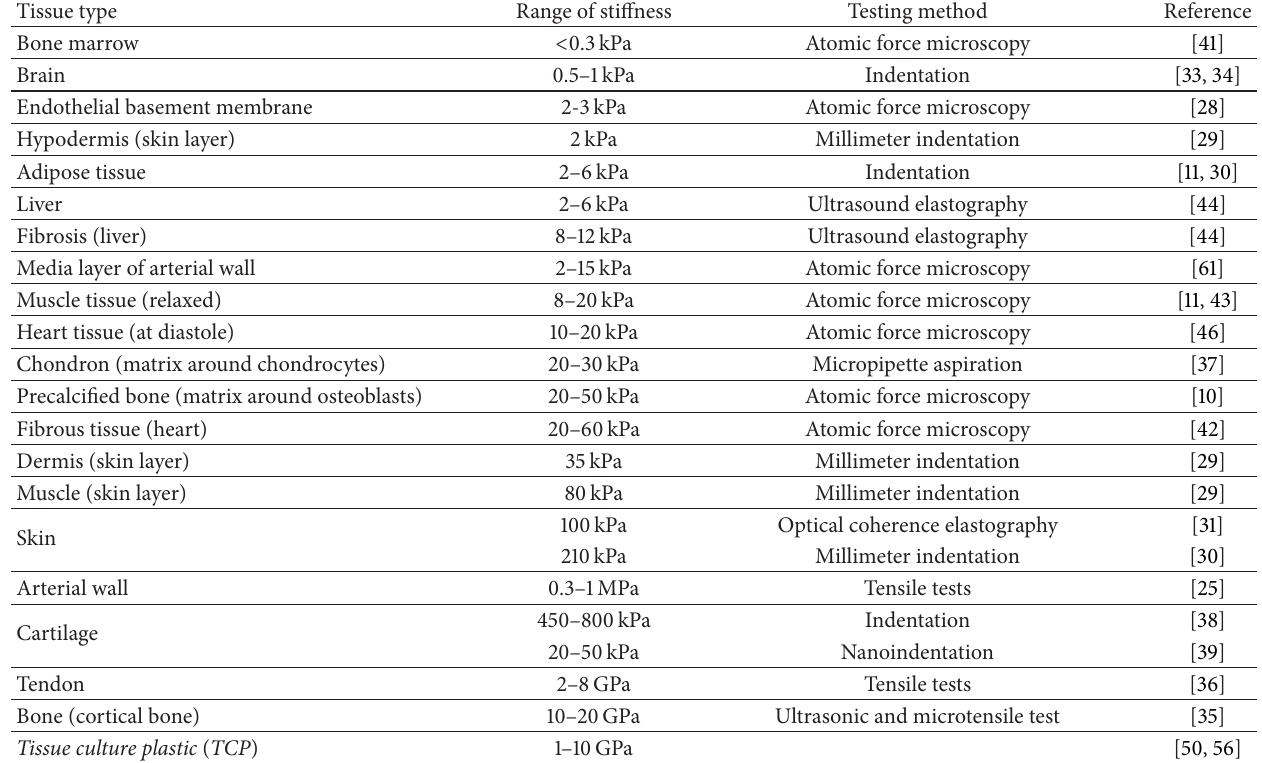
Table 1: Summary of elastic moduli ∗ of mammalian